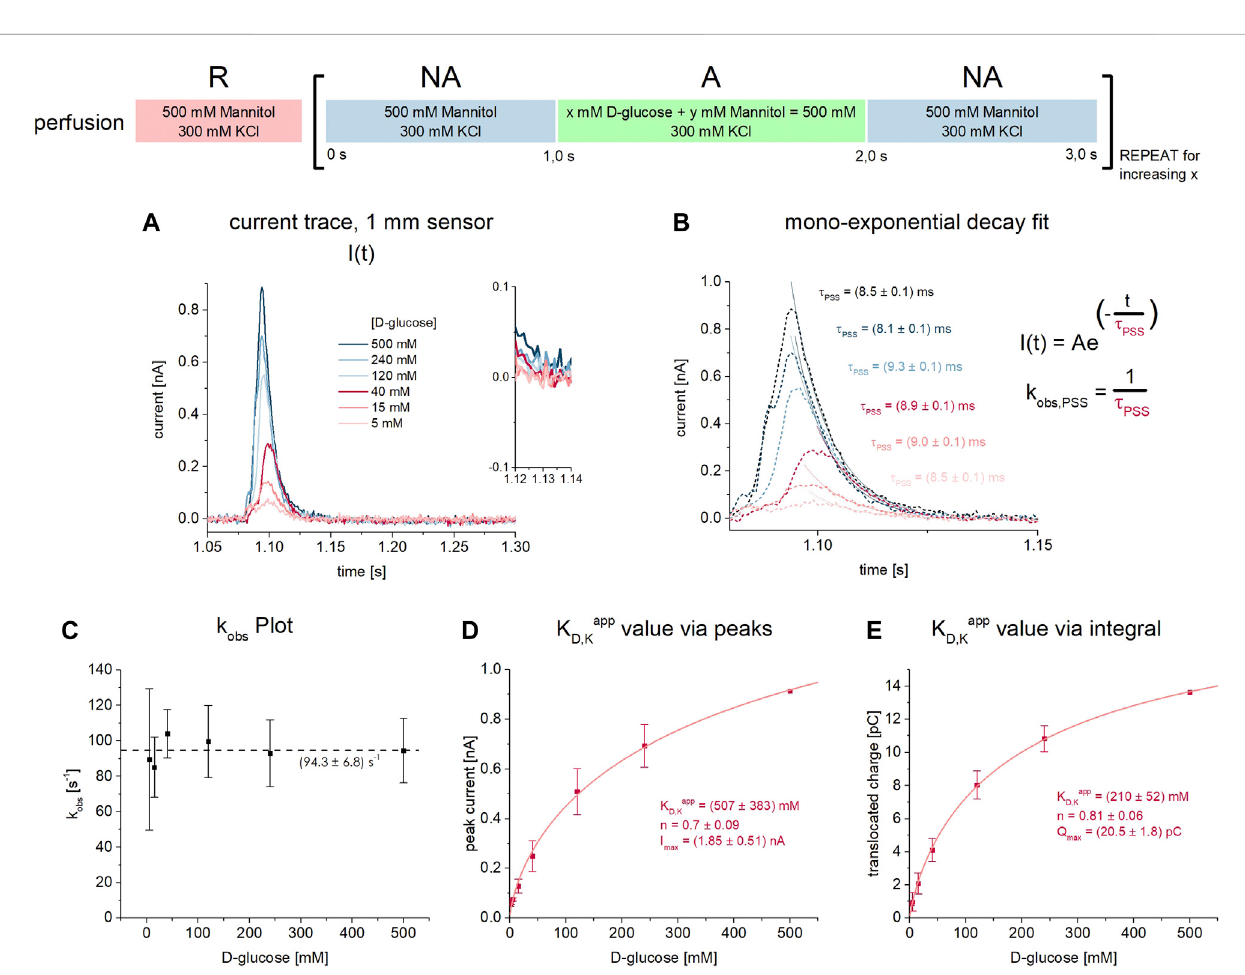
FIGURE 2 D-glucose binding to SGLT1 in absence of co-substrate. All current traces were recorded on 1 mm sensors at pH 7.4 in absence of Na + upon D-glucose concentration jumps between 5 mM and 500 mM. Na + was replaced by 300 mM K + in all measurement solutions. Averaged data of n = 6 different sensors is shown. (A) Representative current traces recorded on one 3 mm sensor. The inset shows the current at t = 1.13 s which already reached the baseline, indicating that only PSS currents upon D-glucose binding are measured. (B) The decay time constant τ is determined from mono- exponential fi ts of the current decay. Rate constants k obs are derived for each sugar concentration. (C) Rate constants k obs = 1/ τ for the sugar- induced PSS reaction are independent of the D-glucose concentration within the tested concentration range. (D) Peak currents are fi tted using a hyperbolic equation to derive a K D,K app of 507 ± 383 mM for D-glucose binding to the empty carrier. (E) Integrals are fi tted using a hyperbolic equation to derive a K D,K app value of 210 ± 52 mM for D-glucose binding to the empty